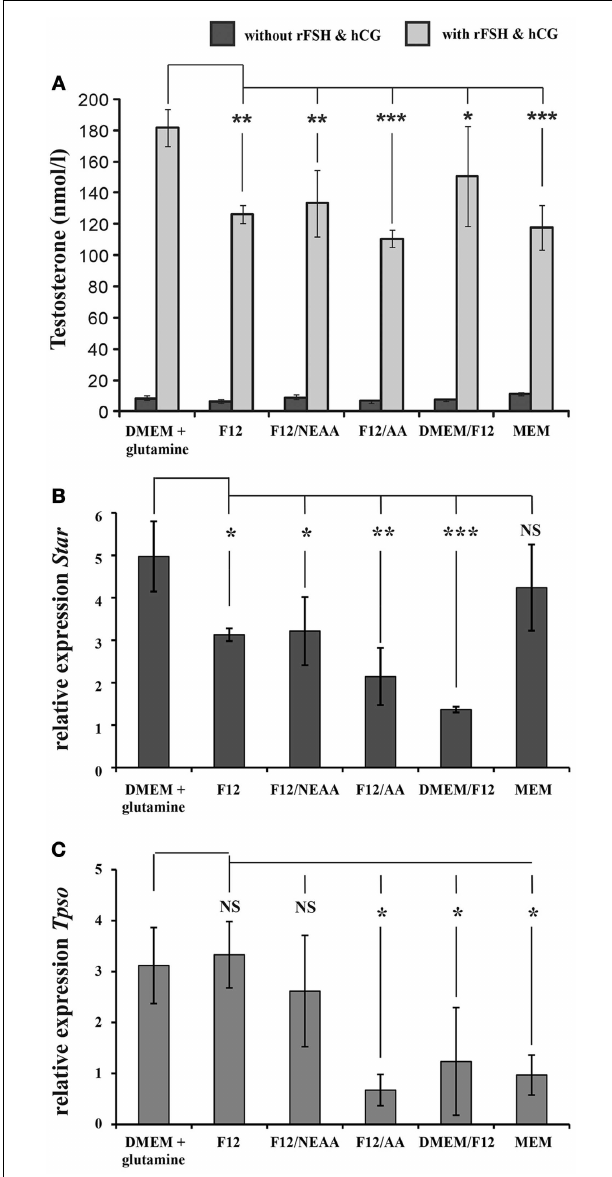
FIGURE 1 |The influence of various culture media on the capacity of the Leydig cells in three-dimensional cultures of rat testicular cells to produce testosterone and express steroidogenic genes . (A) On the X -axis are the different culture media employed [DMEM + glutamine (GL), F12, F12 + NEAA (non-essential amino acids), F12 + AA (essential amino acids), F12/DMEM, and MEM (minimal essential medium)], and the Y -axis depicts the concentration of testosterone (evaluated by radioimmunoassay and expressed in nanomoles/liter) in the medium of cells cultured for 1day. The relative expression of (B) Star (Steroidogenic Acute Regulatory Protein) and (C) Tspo (Translocator Protein) (determined by qPCR analysis with Actb as an internal control) by testicular cell suspensions from 7d pp rats cultured for 1day in six different media in the presence (light columns) or absence (dark columns) of hCG and FSH.The mean relative expression for triplicates was calculated by the ddCt procedure. One-way ANOVA with the Shapio–Wilk test for normality was applied to compare the different experimental conditions. NS: non-significant; * p < 0.05, ** p < 0.01, *** p < 0.001 in comparison to the value with DMEM + glutamine.